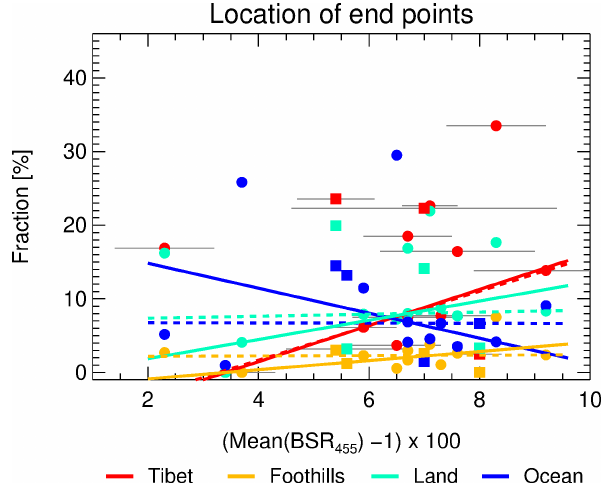
Figure 15. Fractions of Tibet, Foothills, Land and Ocean versus ( BSR 455 -1) × 100 (see Table 1) for the location of the end points of the trajectories (see Table 3). BSR 455 is the backscatter intensity averaged over the ATAL altitude range listed in Table 1 for each flight (for details, see Sect. 3.1). The standard deviation ( σ ) of the backscatter ratio is indicated for each sounding (grey lines). The flights (11, 21, 23 and 26 August) for which the trajectory number is lower than 50% of the maximum number of trajectories (704) calculated on 18 August 2016 are also shown (indicated by squares instead of circles). For each region a linear fit (using the least abso- lute deviation method) was calculated using all measurements ex- cept the one on 12 August (Table 1), when the UTLS is filled by a 5km thick cirrus cloud (dashed lines). Further, a linear fit excluding in addition the flights on 11, 21, 23 and 26 August as well as the no ATAL flight (15 August) is shown (lines). An increase in the frac- tions from Tibet, Foothills and Land is found for increasing ATAL intensity, while the contributions from Ocean decrease for the loca- tions of end